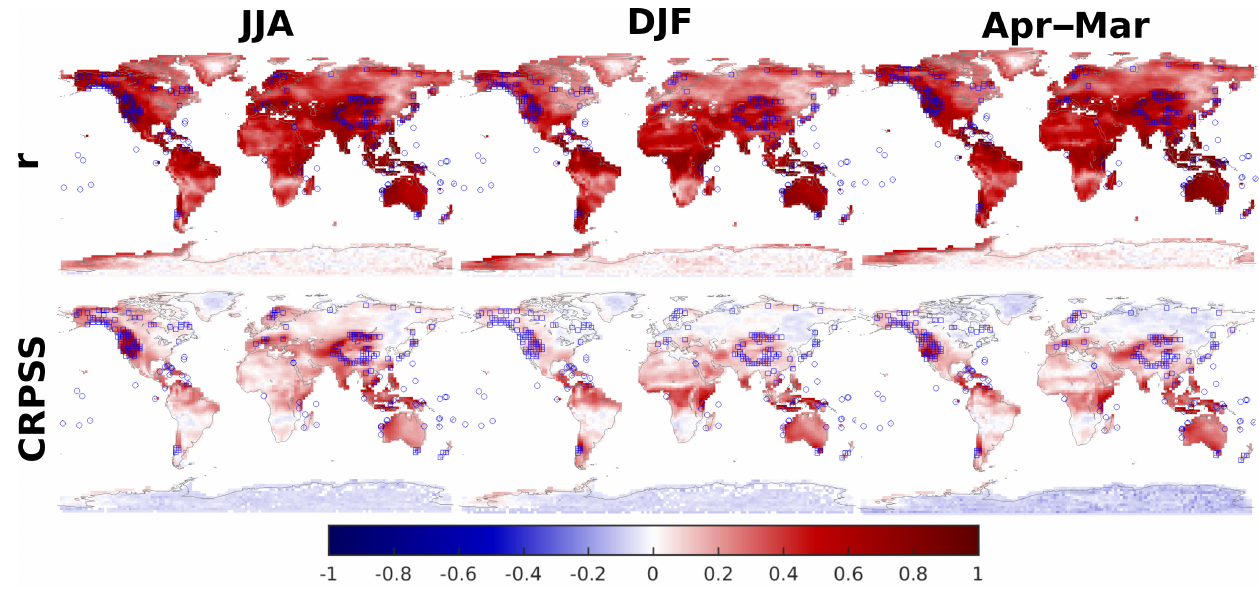
Figure 5. Reconstruction skill, correlation ( r ), and the mean continuous ranked probability skill score (CRPSS) for the standardized precip- itation evapotranspiration index (SPEI) with a 12-month decaying exponential weighting kernel; cf. Figs. 2 and 4.